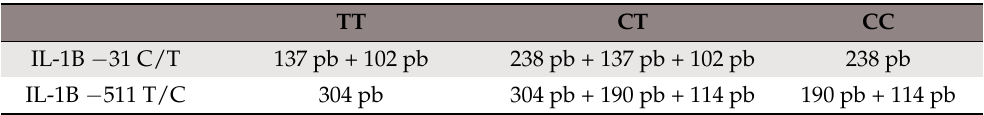
Table 2. Description of visualized fragments after RFLP.